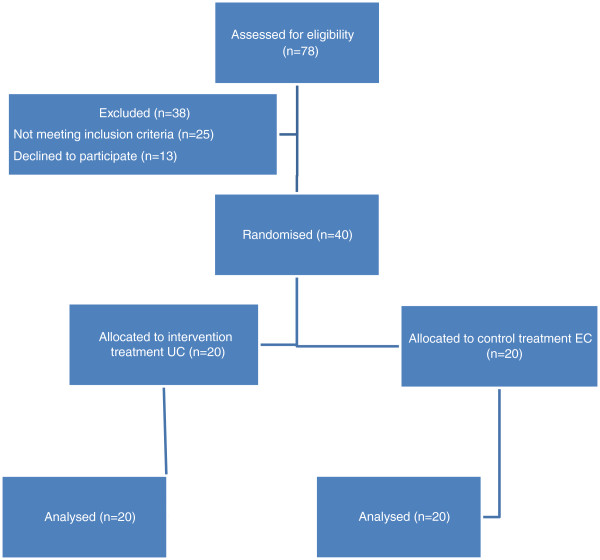
Study flow diagram.